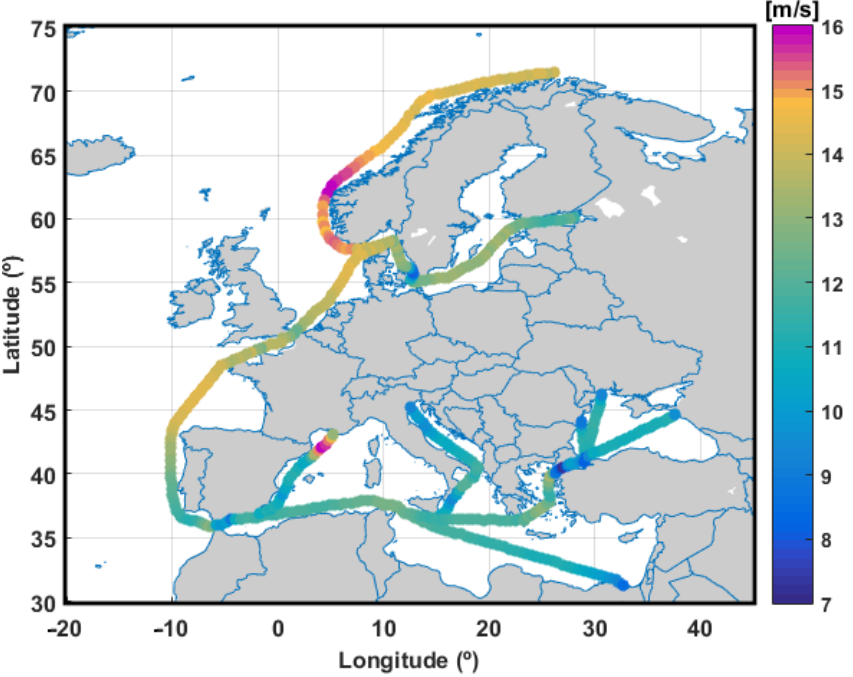
Figure 13. Wind speed 95th percentile along the European maritime routes. Table 3. Maximum wind speed 95th percentile on each route considered in this study. Routes